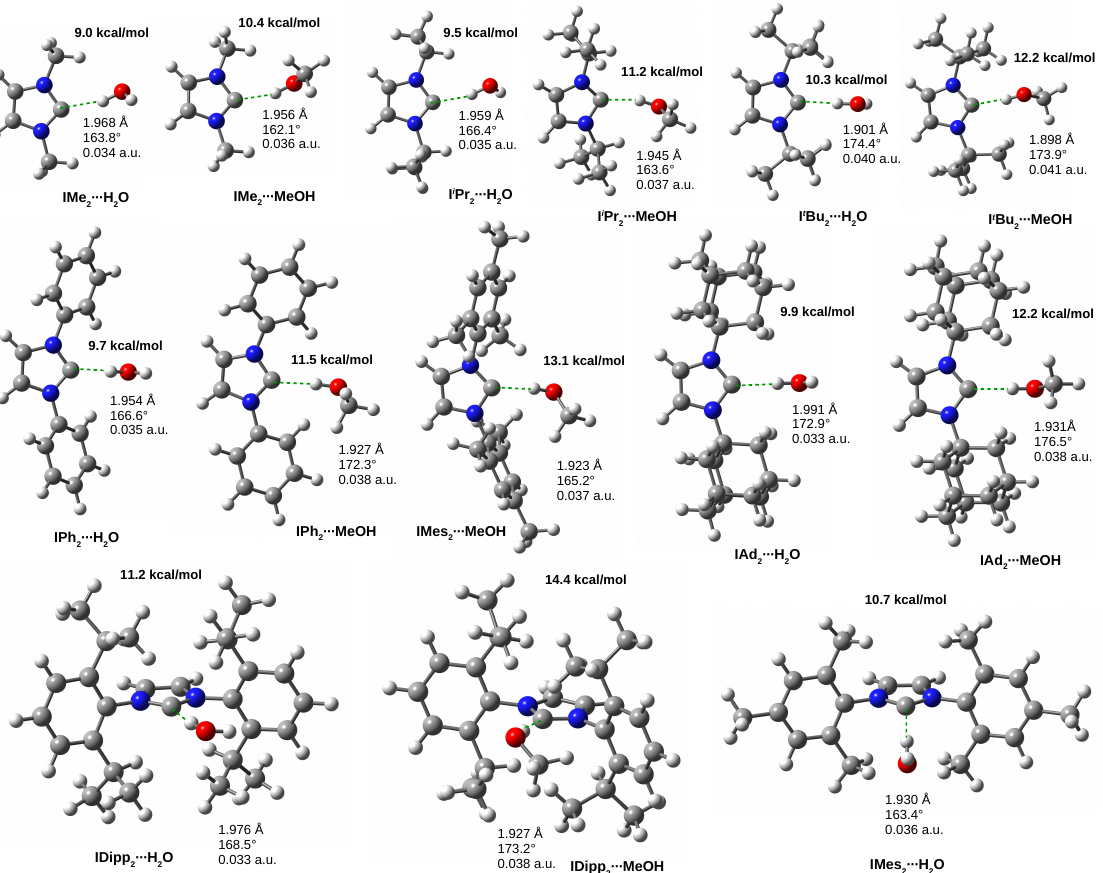
Figure 7. The IR 2 · · · H 2 O and IR 2 · · · MeOH (R = Me, i Pr, t Bu, Ph, Mes, Dipp, Ad) dimers. The values of the dissociation energy are given in bold, while the three values refer to the length of the hydrogen bond, the C-H-D angle and the value of the electron density at the bond critical point of the C · · · H-D hydrogen